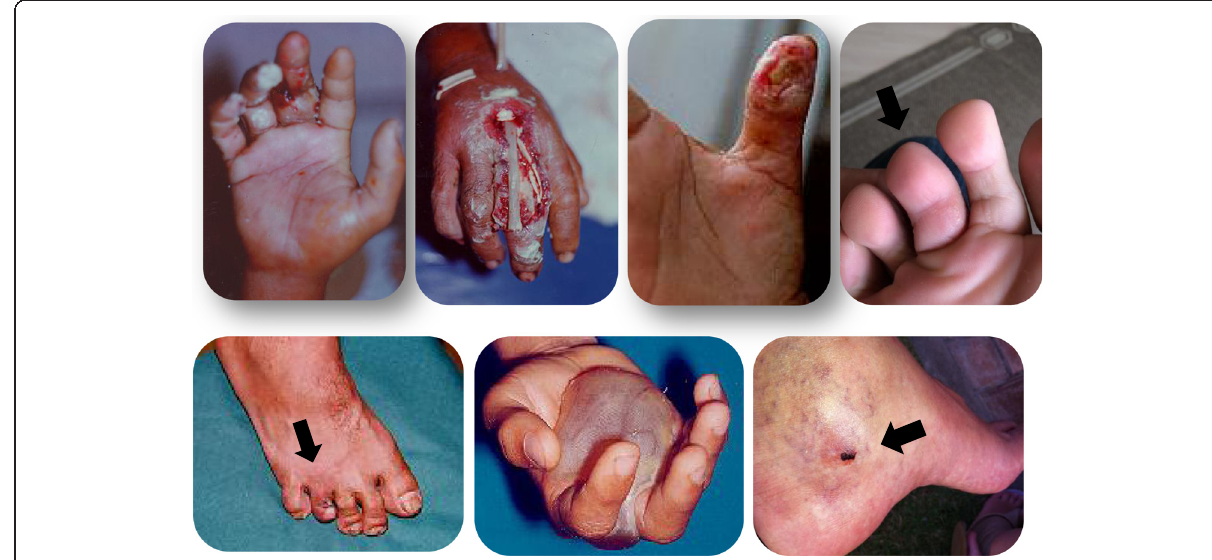
Figure 2 The main manifestations of T. nattereri envenomation. Hands and feet are the most commonly affected areas in humans, which usually present intense necrosis and markedly poor healing